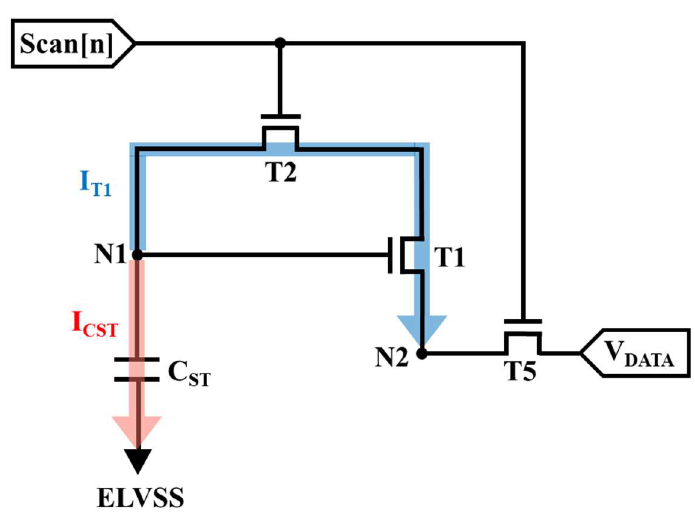
Figure 3. Equivalent circuit of programming stage for the calculation of discharging time.